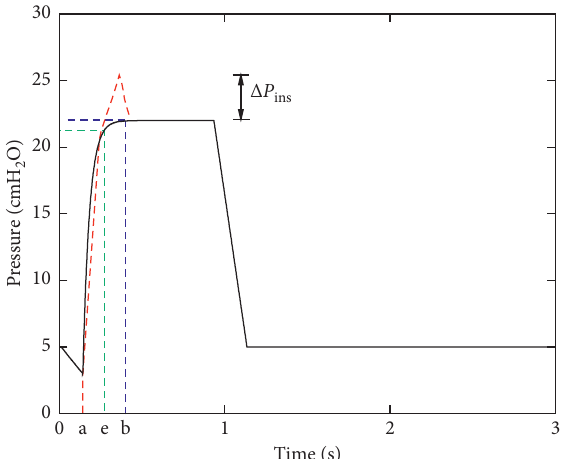
Figure 15: The illustration of the short-term spike during inspiration